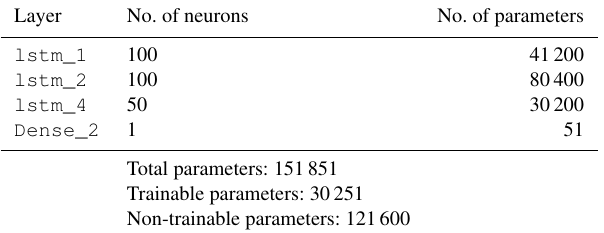
Table 5. Architecture of the transferred LSTM network